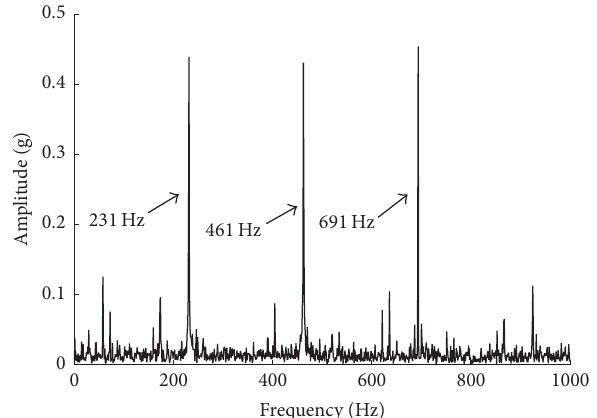
Figure 15: Demodulation result of the 986th